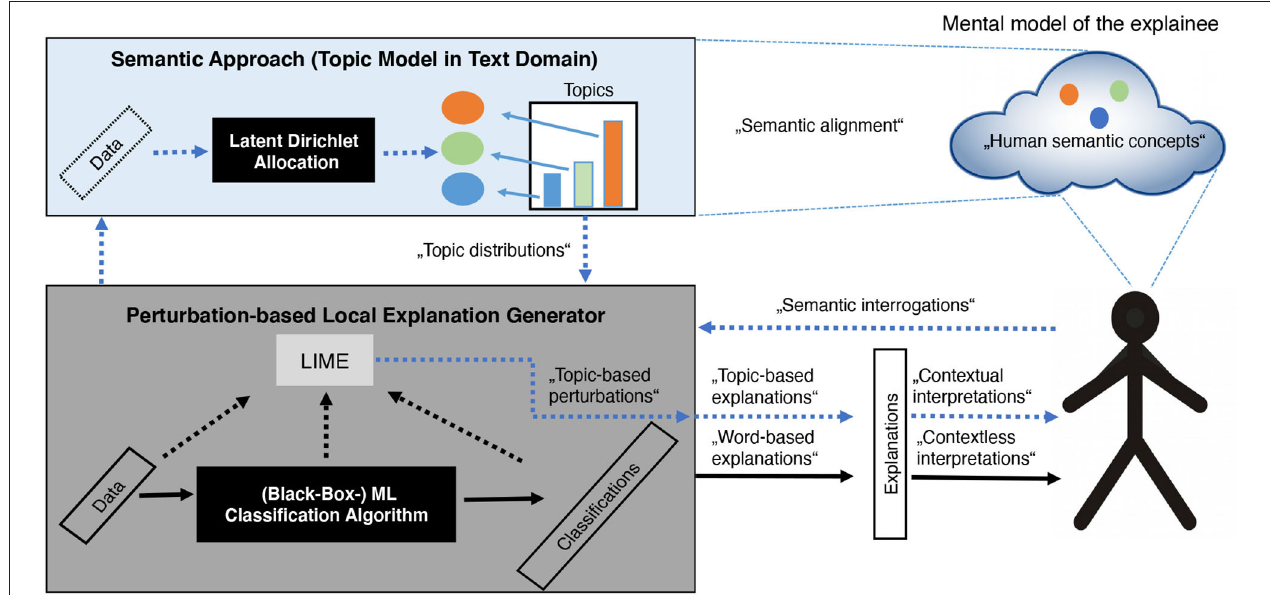
FIGURE 6 | Integration of a ML classification algorithm, an explanation system like LIME as well as a semantic approach: Black arrows represent the classical way of generating and communicating explanations in a model-agnostic and perturbation-based way, while the blue dotted arrows show the explanation process integrating a semantic